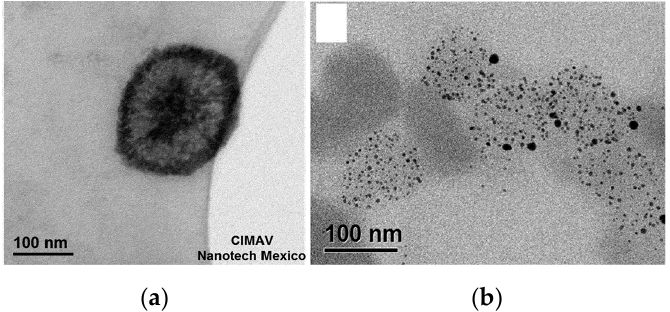
Figure 4. Transmission Electron Microcopy images of the nanogel: ( a ) The nanoparticle before the presence of Au, trough the staining with phosphotungstic acid is revealed in the core-structure (the further outer dark layer is attributed to initiator residues) and ( b ) after the in-situ generation of Au nanoparticles (without staining). Reprinted from Reference [76] by permission of the publisher (Taylor and Francis Ltd, http://www.tandfonline.com), Copyright 2017 Taylor & Francis Group.